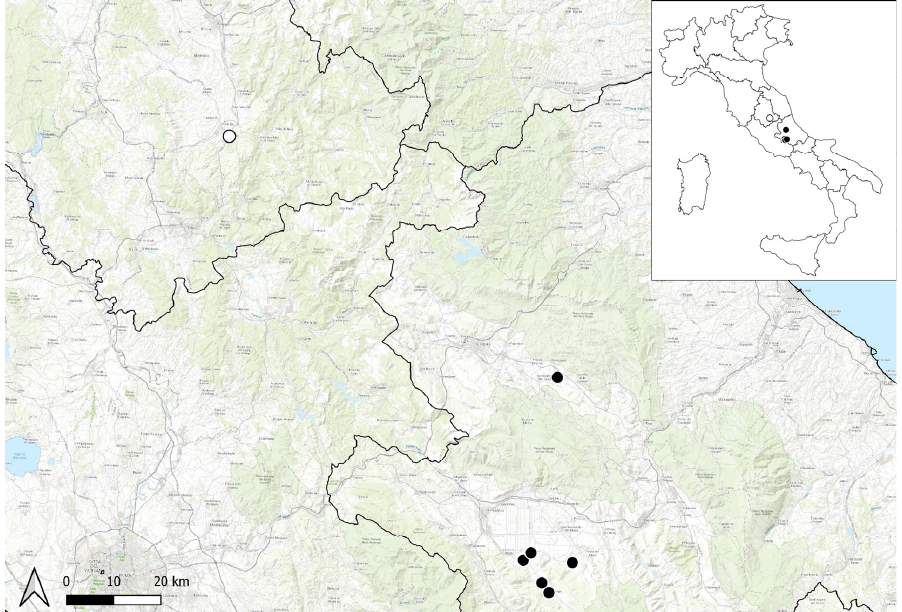
Figure 3. Distribution map of Spiraea hypericifolia subsp. hypericifolia in Italy, according to the herbarium material studied. Black symbols indicate the population currently present based on field investigations, and empty symbols refer to the old herbarium specimens seen.